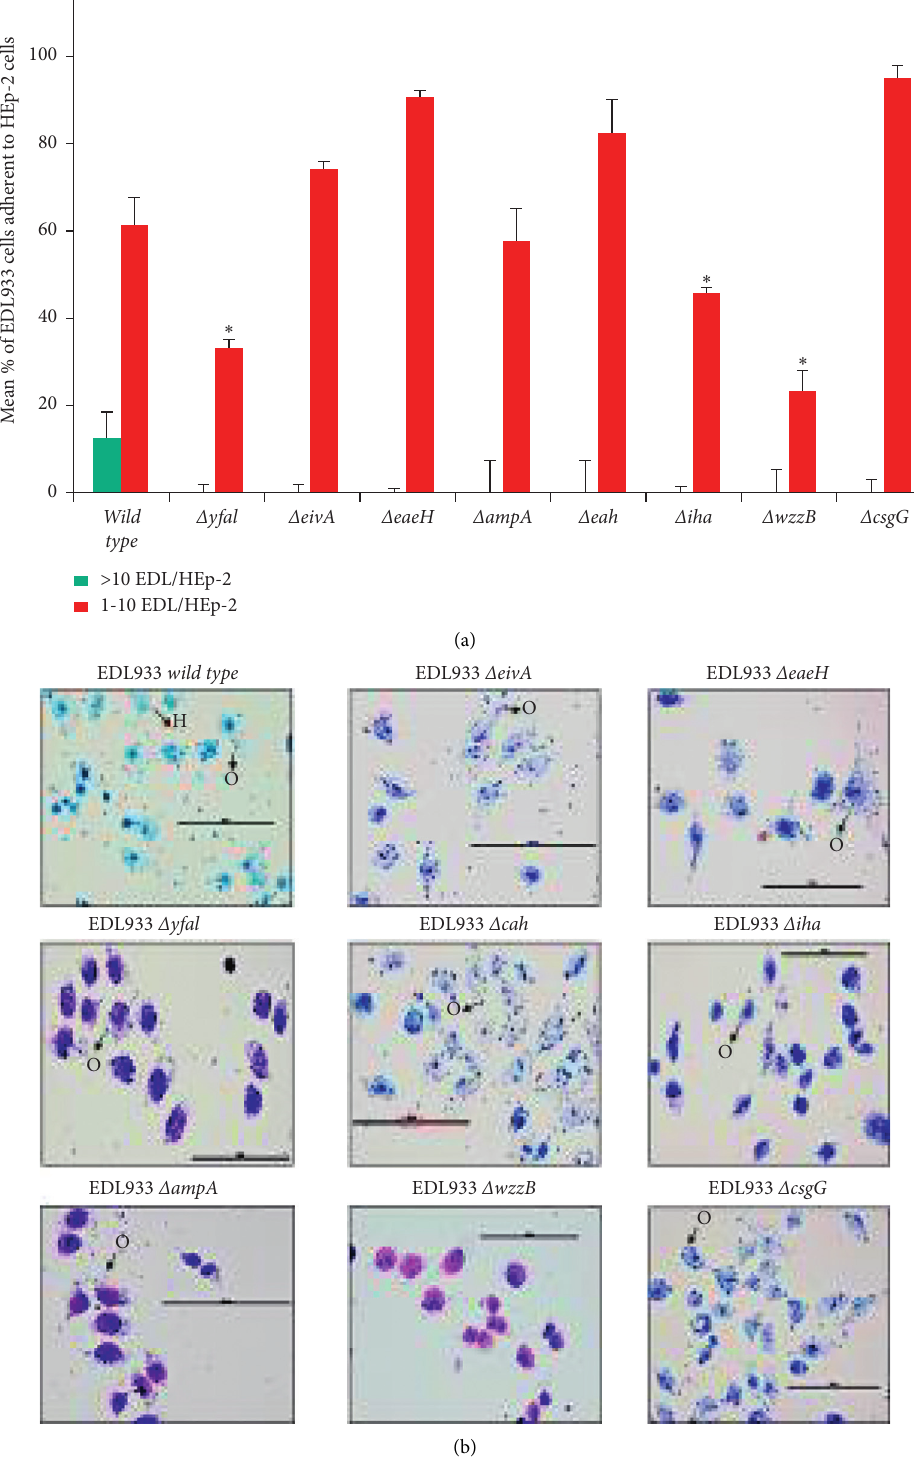
Figure 5: EDL933 adherence mutant phenotypes on HEp-2 cells. Adherence of the parental strain and subsequent adherence-associated gene mutants of EDL933 were tested for adherence quantitatively (a) and qualitatively (b). Both indicate that EDL933 Δ yfaL , Δ iha , and Δ wzzB are all deficient in adhering to the HEp-2 cells compared to wild-type EDL933. (a) Each bar is representative of four technical replicates per slide where 20 cells/spot were counted over two trials. The bar is the mean percentage of adherent bacteria ( > 10 or 1–10) per HEp-2 cell over the two trials. (b) Toluidine blue-stained slides are used to see the “adherence morphology” of EDL933 to HEp-2 cells. The scale bar for each panel is set to 100 μ m. Asterisks denote p value <